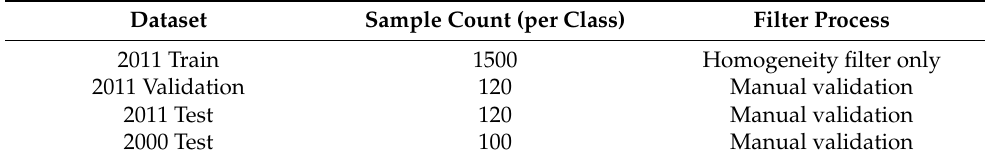
Table 2. Sample count and validation process for each dataset used in model development. The training dataset was used to train all models and the validation dataset was used to choose the best model iteration from training. The two test datasets were used to assess the output classification on previously unseen data from the year it was trained (2011) and a decade earlier (2000). The 3 × 3 homogeneity filter for the training data ensured all pixels neighboring the pixel going into the model were the same class, increasing the chance that the pixel was representative of the intended land cover without the need to manually validate tens of thousands of pixels. Validation and train datasets were manually validated with visual inspection. Dataset Sample Count (per Class) Filter Process 2011 Train 1500 Homogeneity filter only 2011 Validation 120 Manual validation Manual